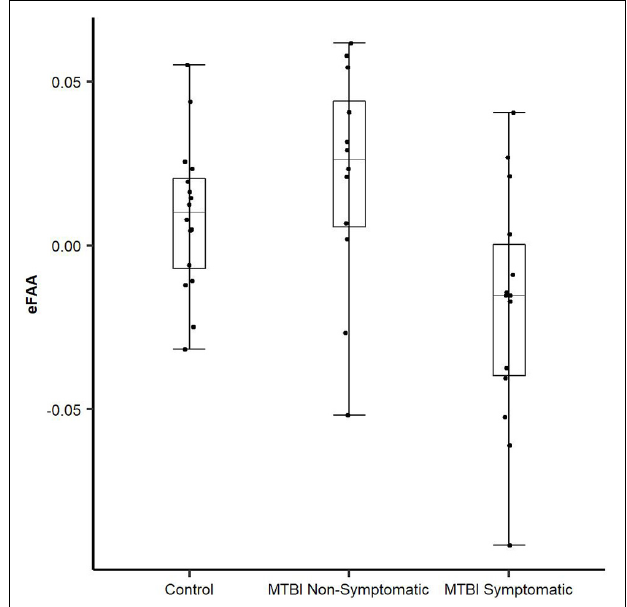
FIGURE 3 | Novel eFAA index differentiates MTBI subjects with symptoms from those without. eFAA, a subtraction score isolating the impact of threat on FAA differed significantly between Symptomatic MTBI and Non-symptomatic MTBI groups and between Symptomatic MTBI group and healthy controls. Symptomatic MTBI group had more negative eFAA index compared to Non-symptomatic MTBI group and healthy controls, indicating altered modulation of FAA by threat in symptomatic MTBI